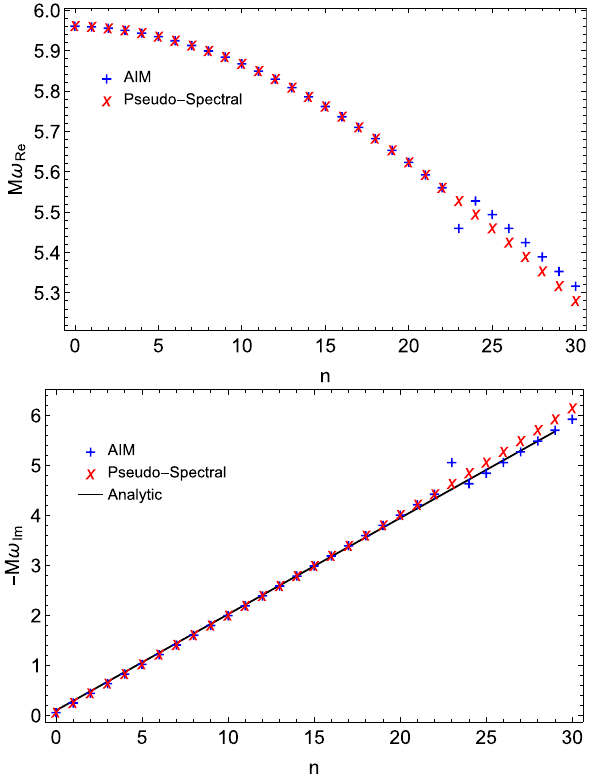
Fig. 4 The figure shows the real (top panel) and imaginary (bottom panel) parts of the frequency as a function of n for the spin s = 1 / 2 field in the case (cid:6) = 30. The crosses ( + ) represent the AIM results, the exes (x) indicate the pseudo-spectral, while the solid black line in the bottom panel is the plot of the function M ω Im given in Eq.